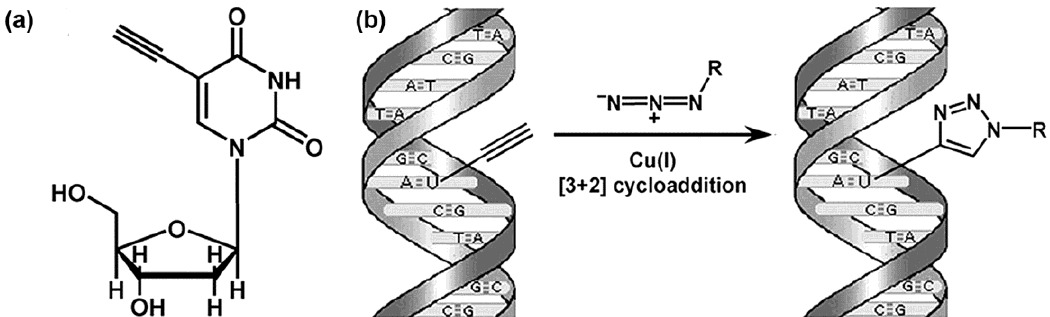
Figure 6. The use of EdU to label DNA in cells. (a) Structure of EdU. (b) Scheme of the click reaction for detecting EdU incorporated into cellular DNA. The terminal alkyne group, exposed in the major groove of the DNA helix, readily reacts with an organic azide (R can be any fluorophore, hapten, electron-dense particle, quantum dot, etc.) in the presence of catalytic amounts of Cu(I). Adapted with permission from Salic, A., Mitchison, T.J., 2008, A chemical method for fast and sensitive detection of DNA synthesis in vivo. Proc Natl Acad Sci U S A 105, 2415–2420, Copyright (2008) National Academy of Sciences U.S.A. [76].